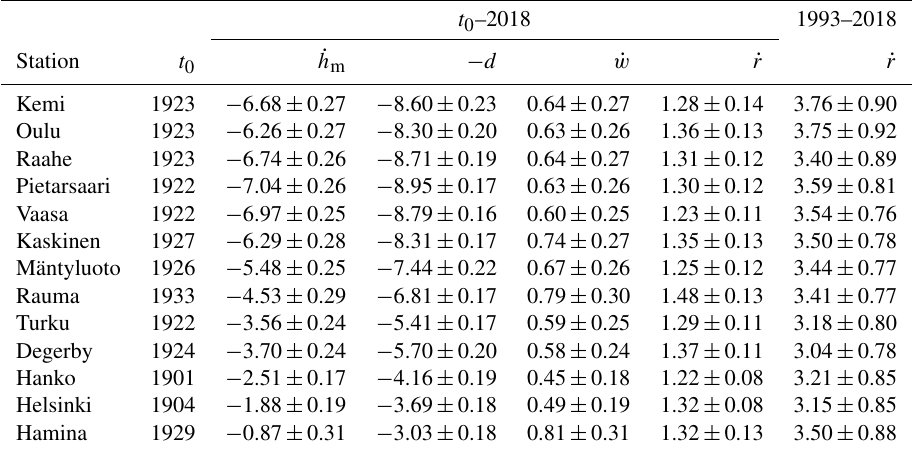
Table 3. Historical trends (millimetres per year) of observed mean sea level h m and its components: land uplift d , wind-induced component w , and regional sea level rise r . Error estimates are 1 SD. The trends are calculated from the beginning of the observations ( t 0 ) to 2018; the trend of regional sea level rise r is also shown for